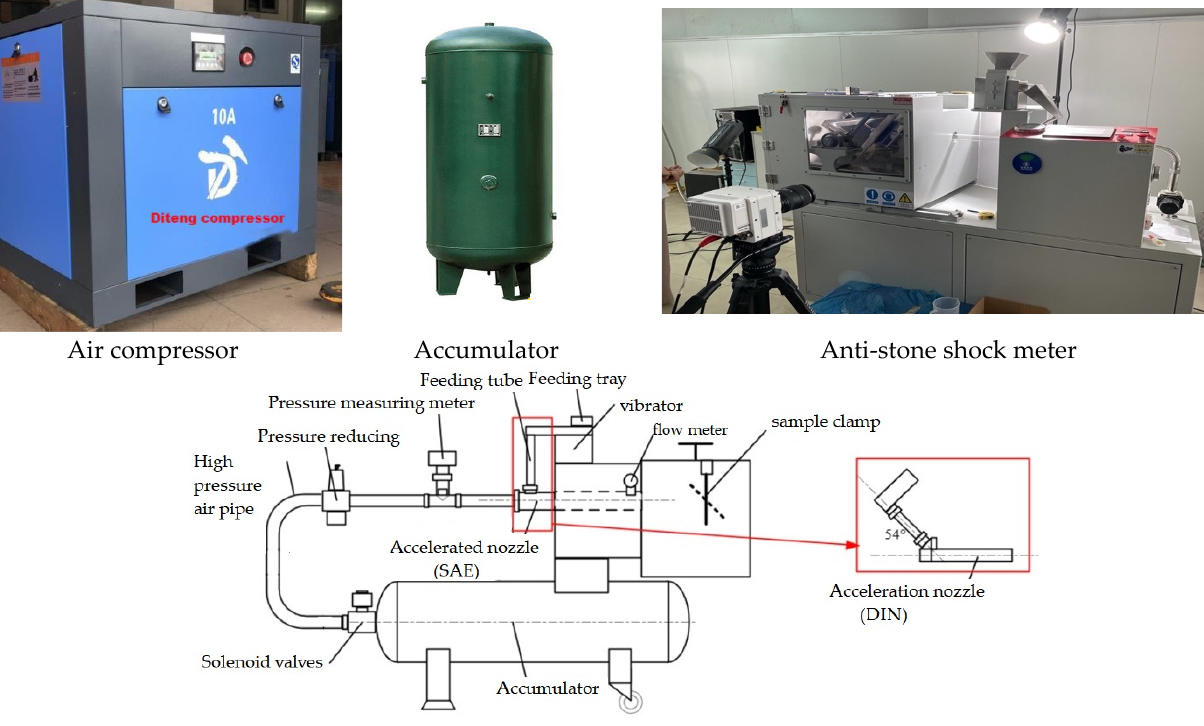
Figure 3. Anti-stone-impact experimental device.